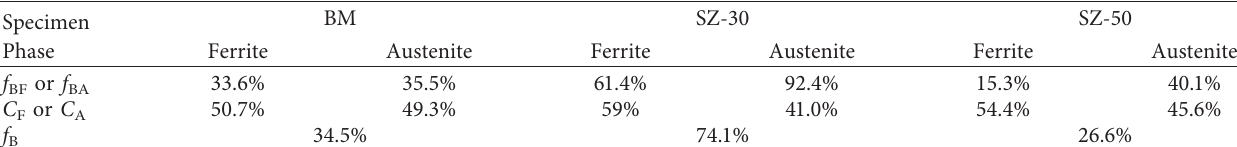
B for different specimens.